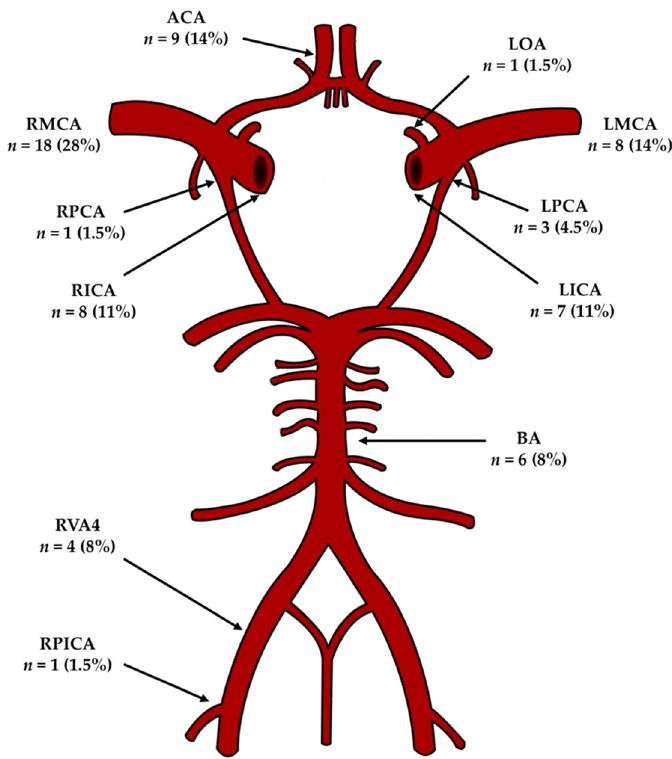
Figure 1. Diagram showing the locations of the 66 aneurysms on the circle of Willis. ACA, anterior communicating artery; LOA, left ophthalmic artery; LMCA, left middle cerebral artery; LPCA, left posterior communicating artery; LICA, left internal carotid artery; BA, basilar artery; RPICA, right posterior inferior cerebellar artery; RVA4, segment V4 of the right vertebral artery; RICA, right internal carotid artery; RPCA, right posterior communicating artery; RMCA, right middle cerebral artery.